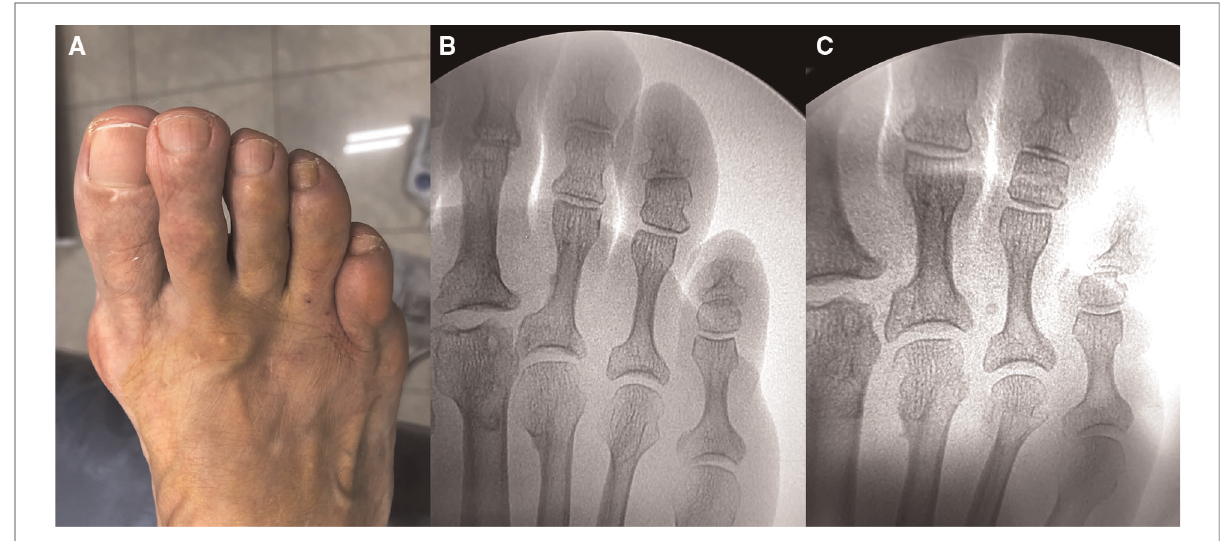
Before After Differences p -value surgery surgery Mean Mean Mean range range range (SD)